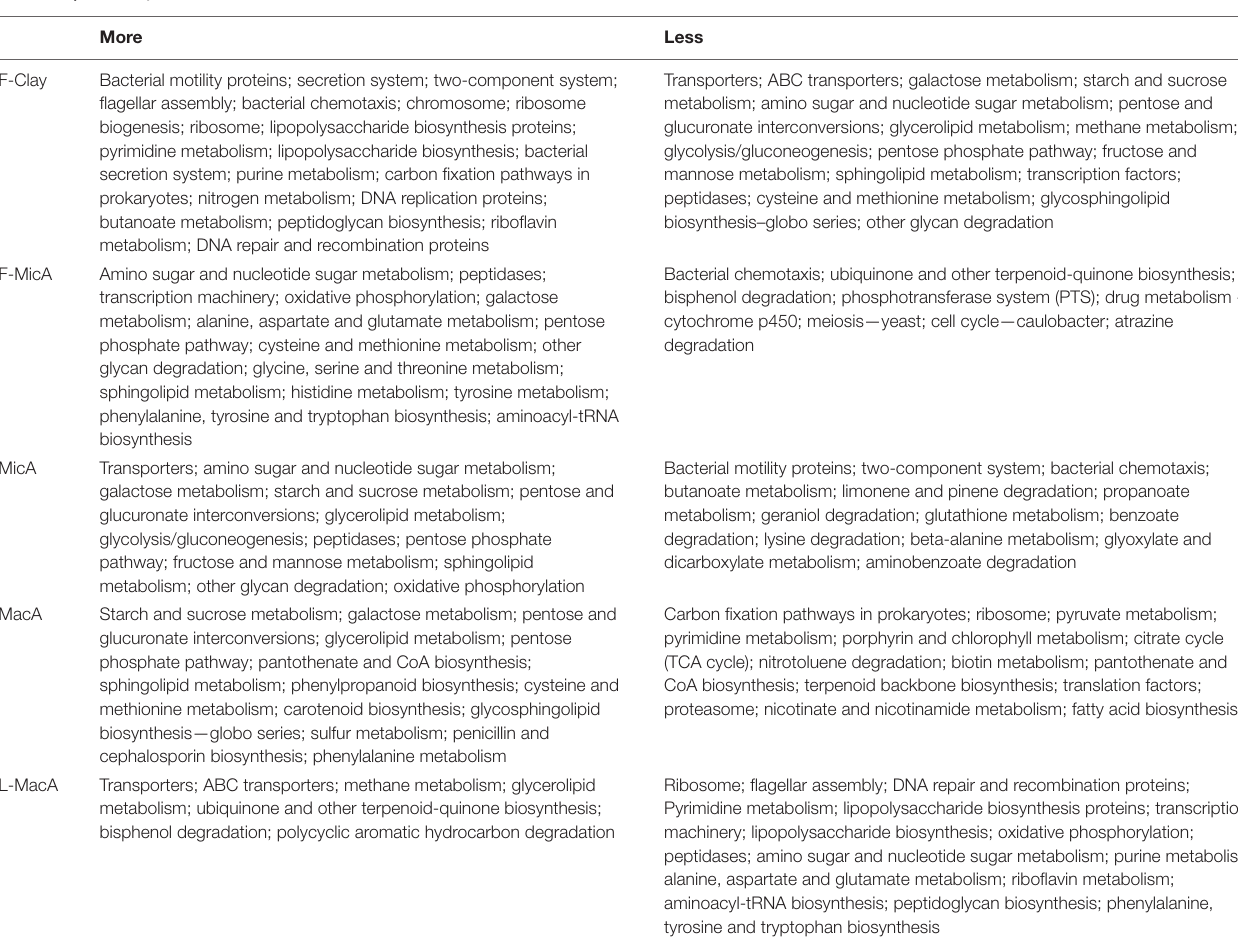
TABLE 5 | Summary of the PICRUSt results of 16S rDNA at KEGG